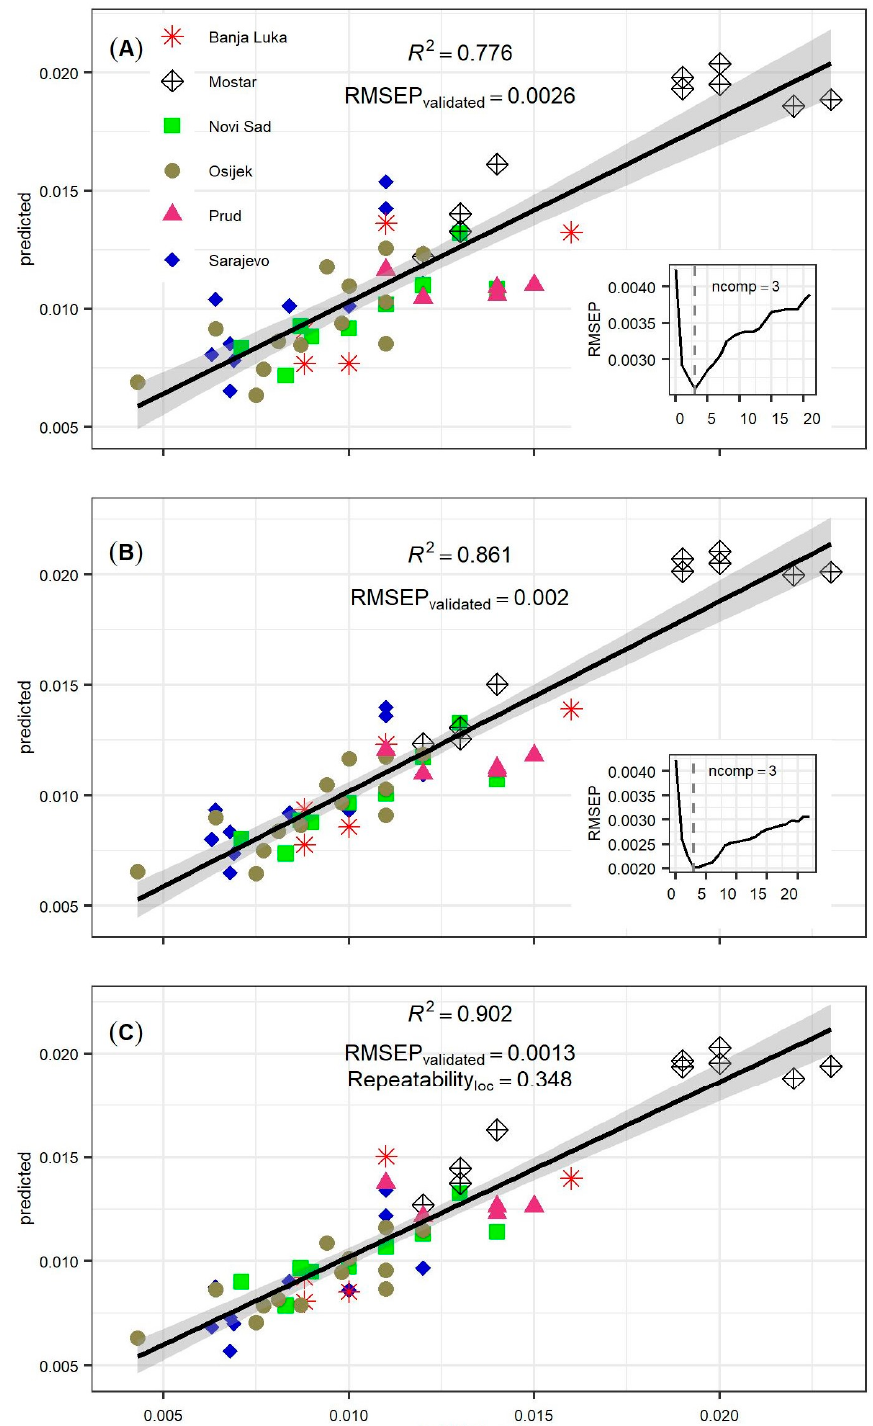
Figure 5. Partial least squares (PLS) regression model for Se H2O, including soil properties and concentrations of other elements ( A ), Se Tot ( B ), and PLS scores from ( B ) along with location main e ff ect in a mixed model ( C ). Respective validation errors, the selected number of components, and repeatability of the location random e ff ect are shown within plots.